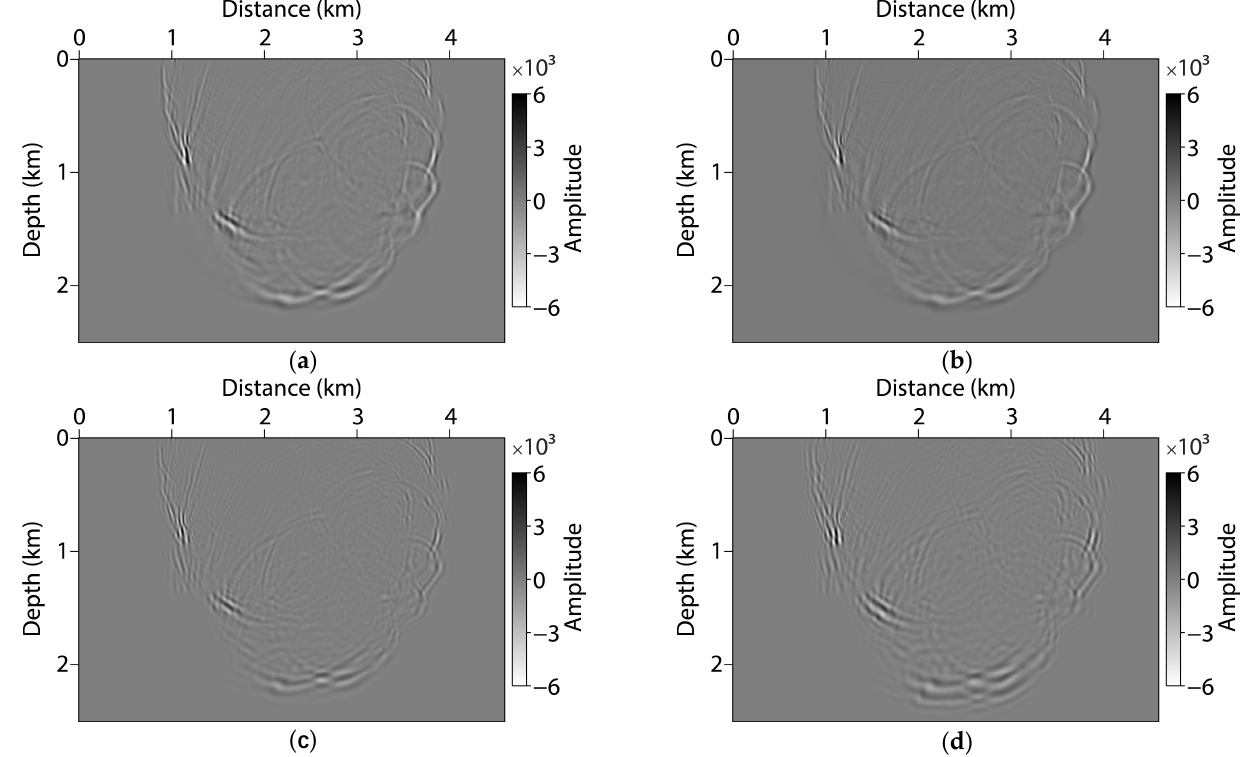
Figure 7. Snapshots of the Marmousi model at 0.5 s. They are simulated by: ( a ) CFD4 scheme, ( b ) CFD6 scheme, ( c ) OCFD4 scheme (0.5 π ), ( d ) OCFD4 scheme (0.75 π ), and ( e ) OCFD4 scheme ( π ), respectively. The red arrows indicate the dispersion error.